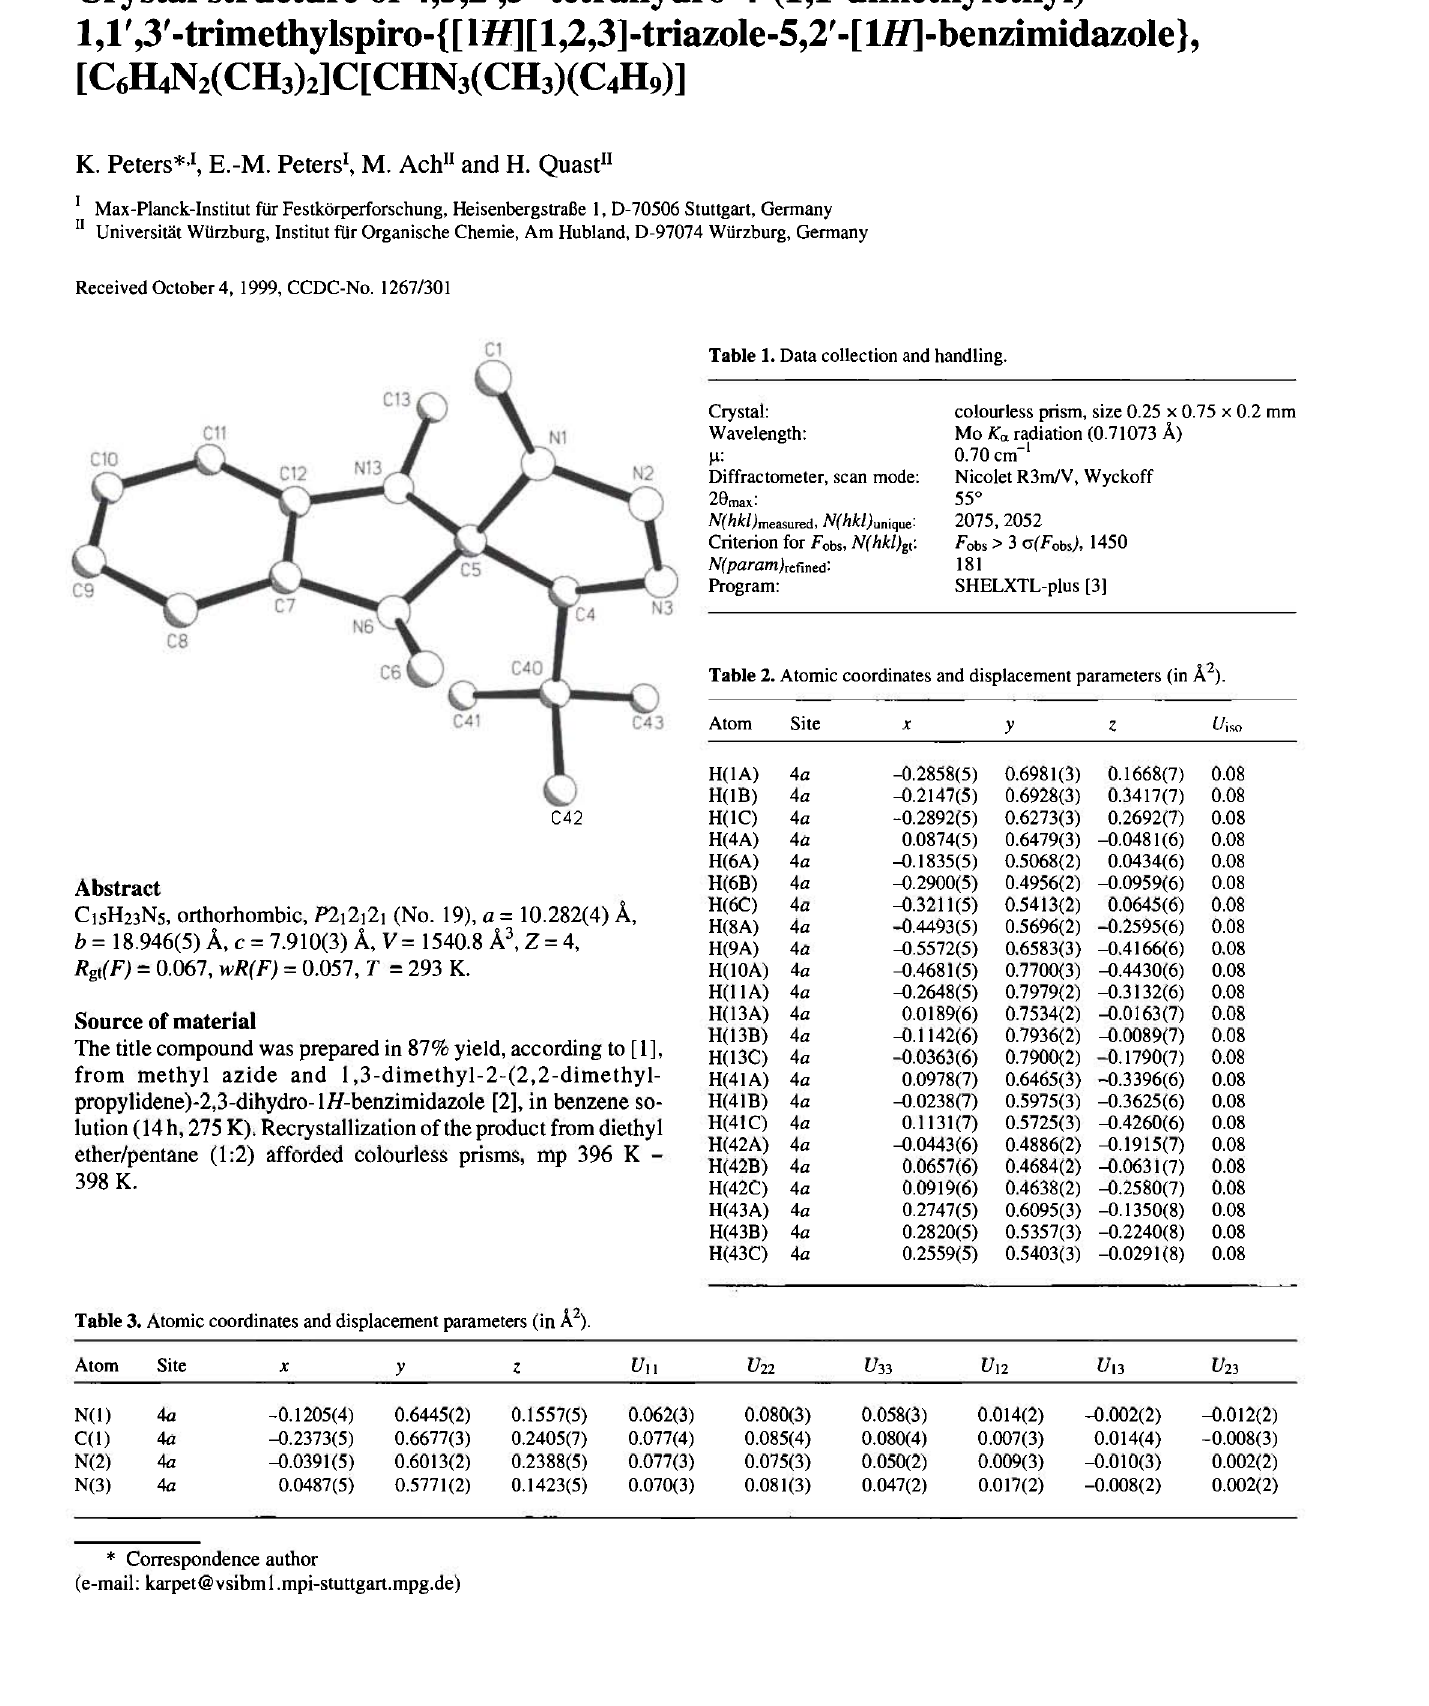
Table 1. Data collection and handling.